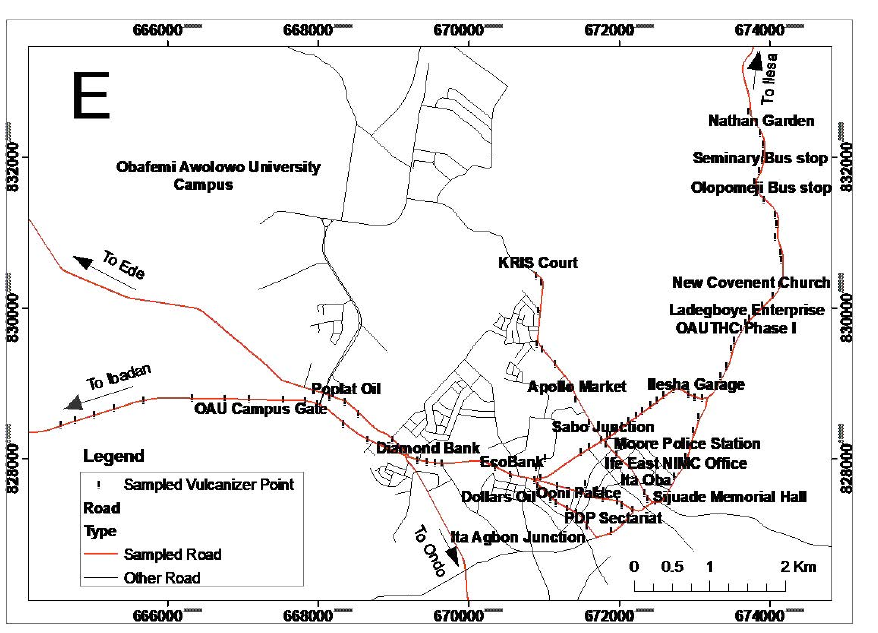
Figure 3. Distribution patterns of vulcanizers in the study